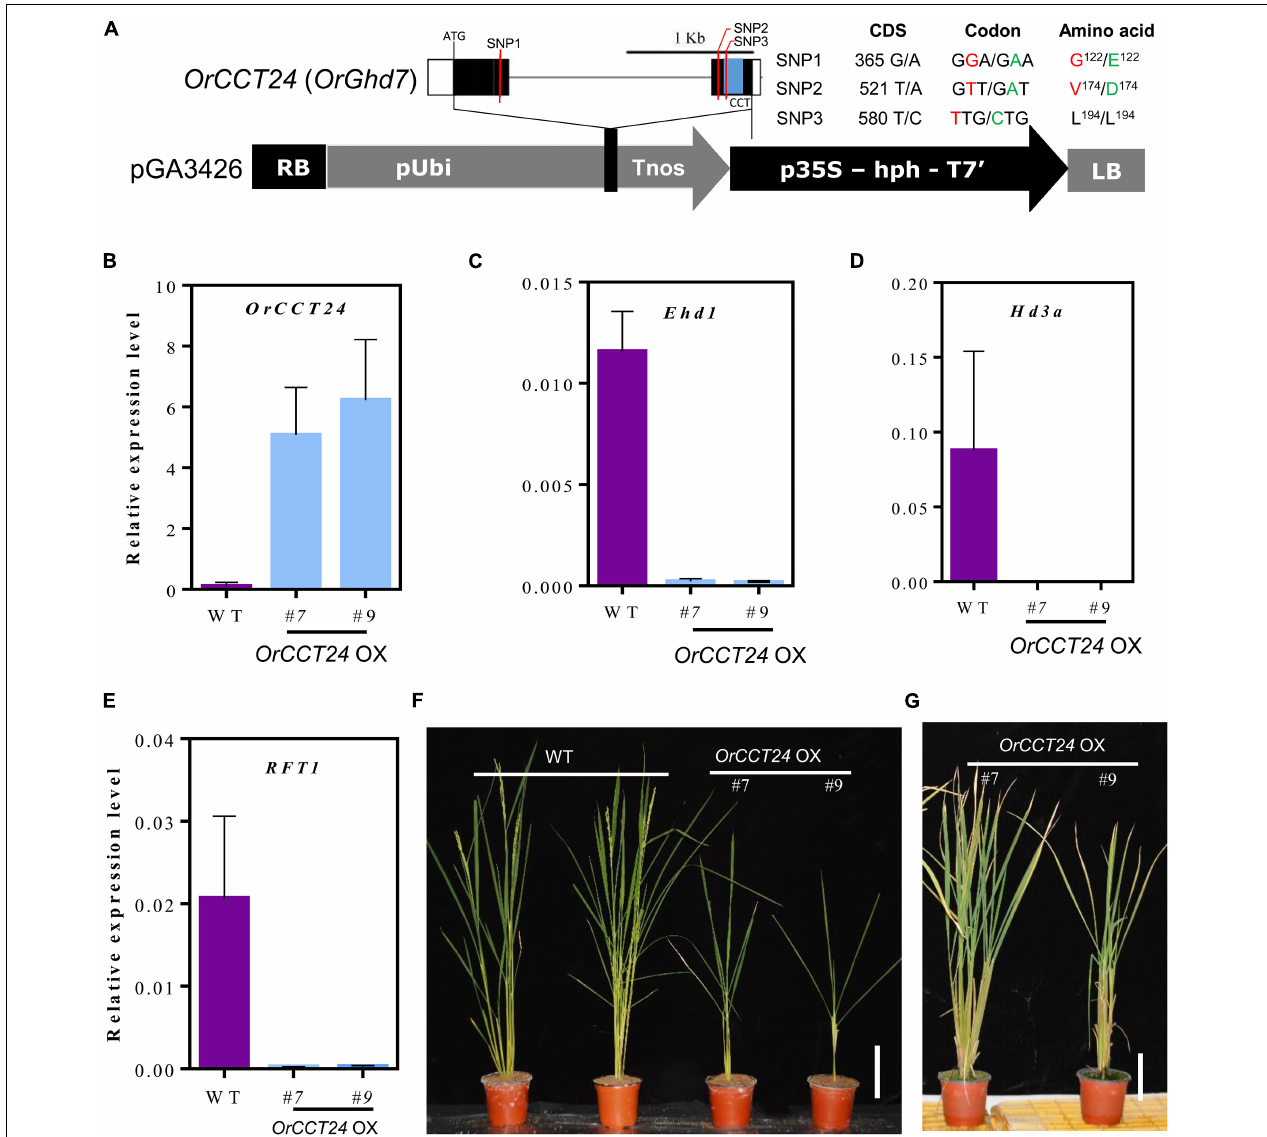
FIGURE 8 | Expression and phenotype analyses of OrCCT24 -overexpression plants under LD condition. (A) Scheme of OrCCT24 overexpressed vector. (B–E) The expression level of OrCCT24 (B) , Ehd1 (C) , Hd3a (D) , and RFT1 (E) in WT and OrCCT24 -overexpressed plants. The transcript levels were relative to OsUbi1 . Error bars indicate standard deviations ( n = 5). Leaf blades were harvested at ZT-2 h at 60 DAG. (F) Phenotypes of OrCCT24 -overexpressed plants (T0 generation) compared with WT at 90 DAG. (G) Phenotypes of OrCCT24 overexpressed plants at 220 DAG. Scale bar = 10